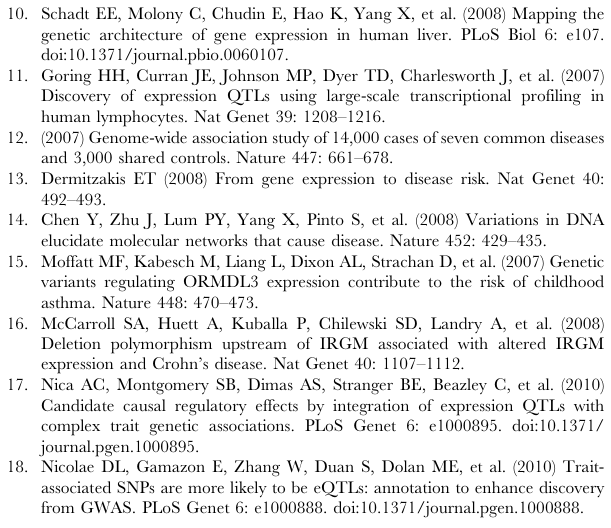
Figure S9 Fold change within twins and across tissues for FAT eQTLs (10 2 3 PT, SRC) discovered in Twin 1. Fold change was calculated as the difference in mean expression of the heterozygous and major homozygous genotypic classes. For each pairwise tissue